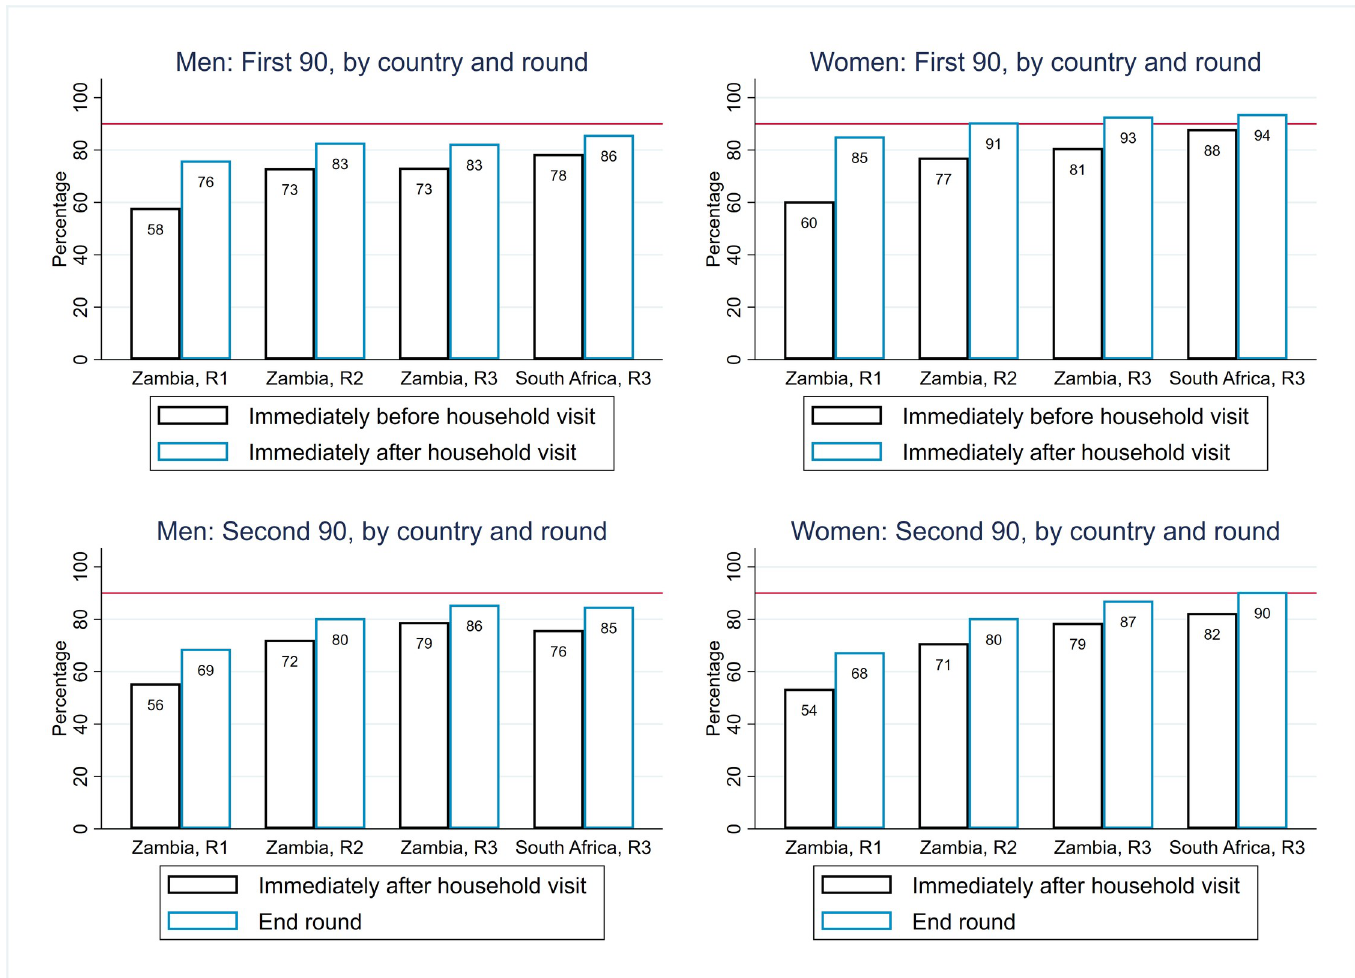
Fig 9. Arm B: Estimates of coverage against the first and second 90 targets, by sex, country, and round (with extrapolation to the total population). R1, Round 1; R2, Round 2; R3, Round 3.